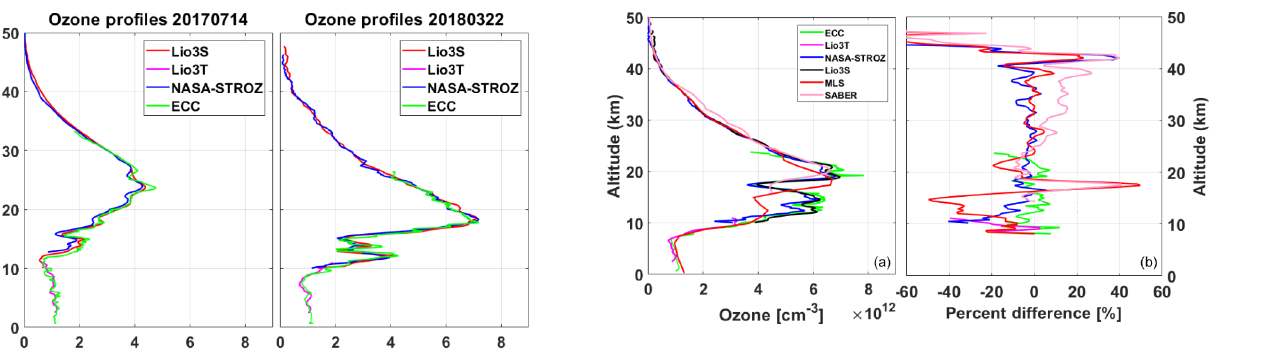
Figure 4. Satellite and lidar ozone profiles measured on the night of 19–20 March 2018 at or near Observatoire de Haute-Provence (a) . Percent differences for each profile with respect to the LiO 3 S pro- file (b) . All profiles have been converted to the same 300m vertical spacing altitude grid. For MLS and SABER, the weighted average profile is calculated based on the distance in time and space between the individual satellite profiles and the OHP